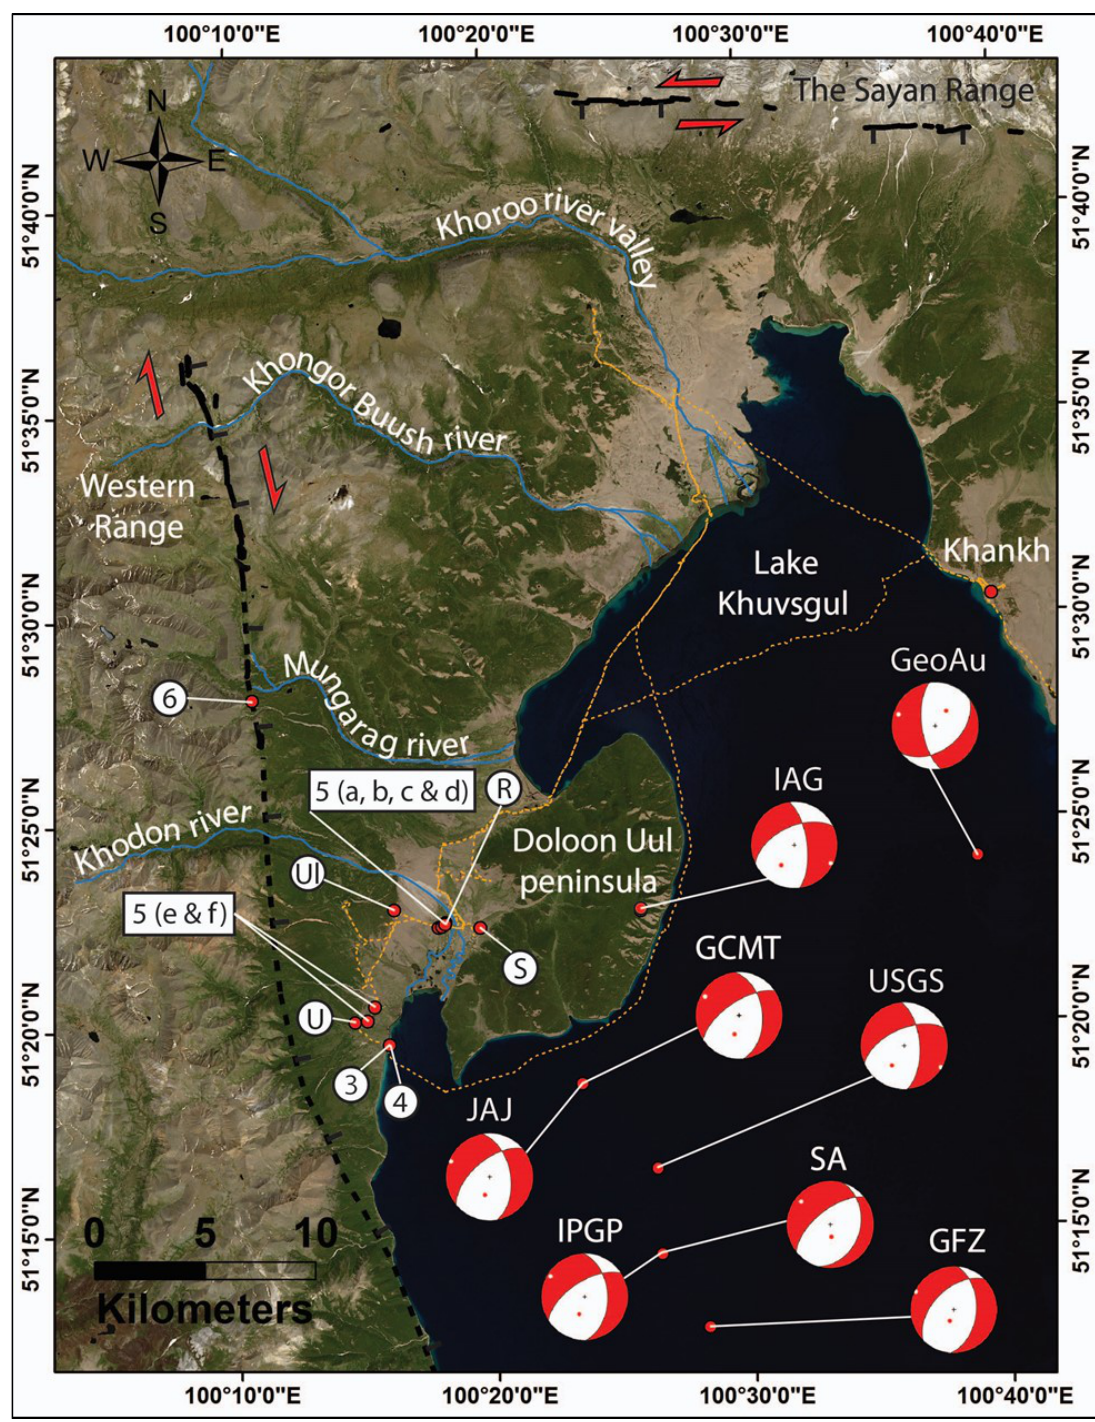
Fig. 2. The epicenter area of the Doloon Uul peninsula. The Base Map is based on the Landsat 8 image. Tectonic scarps of Khuvsgul and Sayan faults are marked by the thick black lines. The dashed black line is the inferred Khuvsgul fault. Golden dashed lines are our tracks during the field research work. Capital letters (U, Ul, R and S) represent the locations of the herder families who are Ukhnaa, Ulziibat, Rinchen and Sodkhuu where we collected the macro-data. Numbers of 3, 4, 5 and 6 express the locations of the field photographs for Figs. 3, 4, 5 and 6 respectively. Fault plane solutions are modified from the official websites and personal communications. See the Table 1 for the detailed